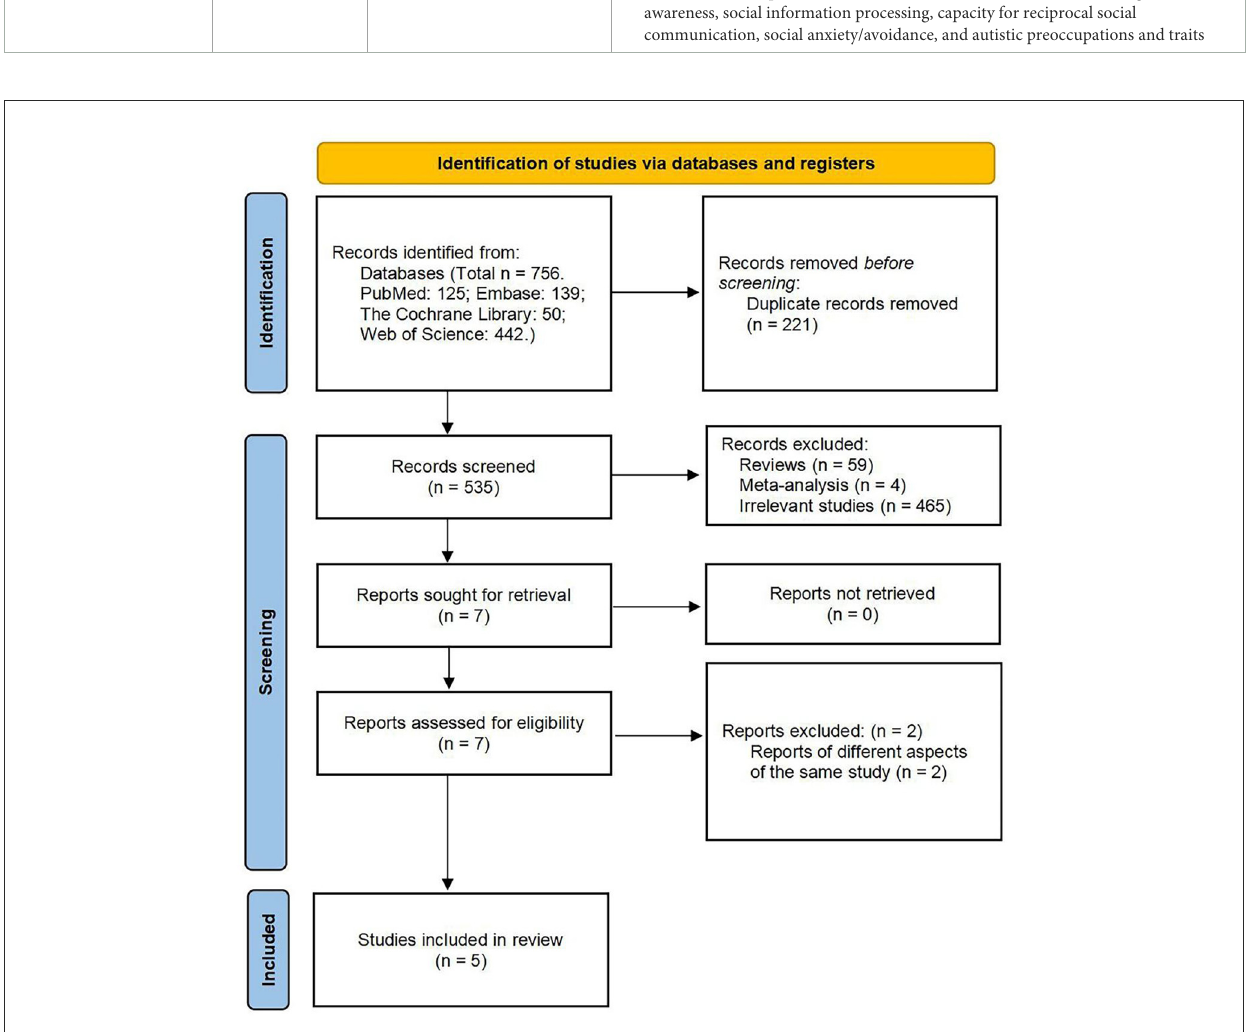
FIGURE1 Preferred reporting items for systematic reviews and meta-analyses (PRISMA) 2020 flow diagram of the study selection process.